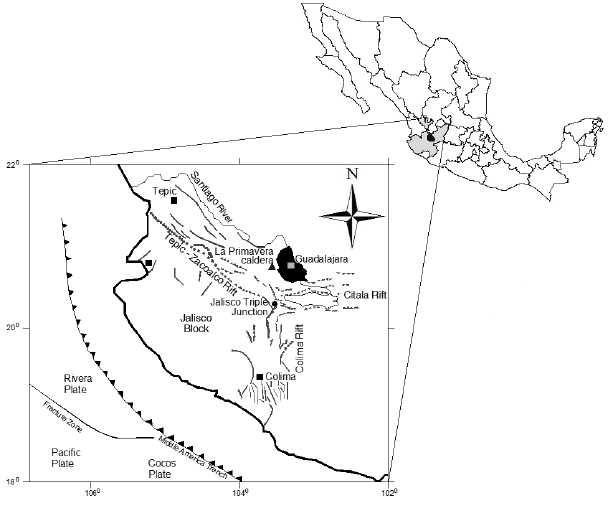
Figure 1. Location of study area (black area) in Mexico and tectonic structures of western Central